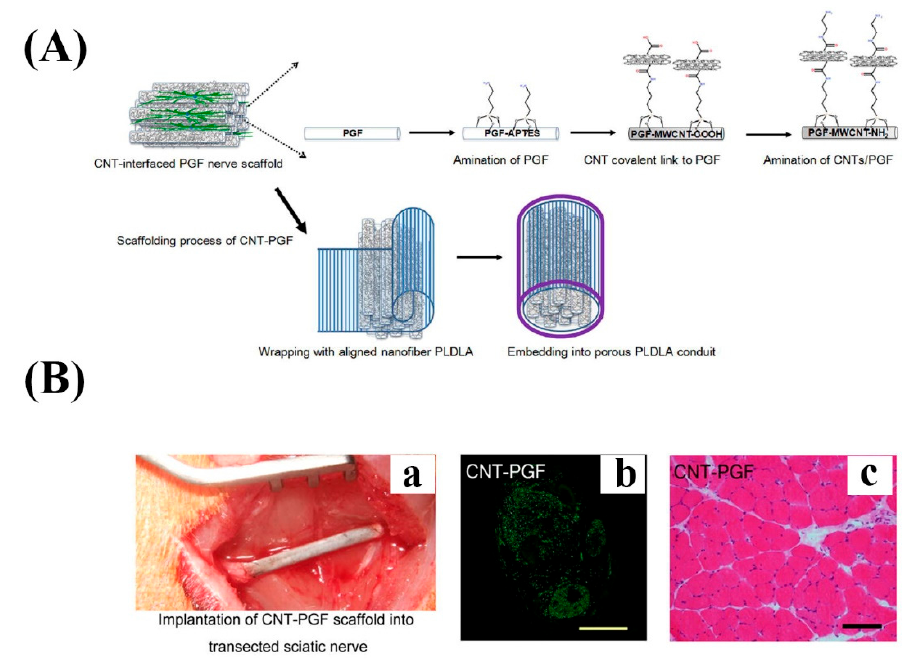
Figure 6. ( A ) Schematic illustration of aminated phosphate glass fibers (PGFs) interfaced with carbon nanotubes (CNTs) through carboxyl groups to wrap around a poly(L/D-lactic acid) (PLDLA) electrospun nanofiber mat and fabricate a porous PLDLA cylindrical tube. ( B ) In vivo implantation of the composite scaffolds into the proximal and distal stumps of a completely transected sciatic nerve of rats (a) and histological and immunohistochemical images at 16 weeks post-implantation (b, c) clarifying the regenerative effect of the scaffolds. Yellow scale bar = 500 µm, black scale bar = 50 µm. Reproduced with some modifications from ref [79].